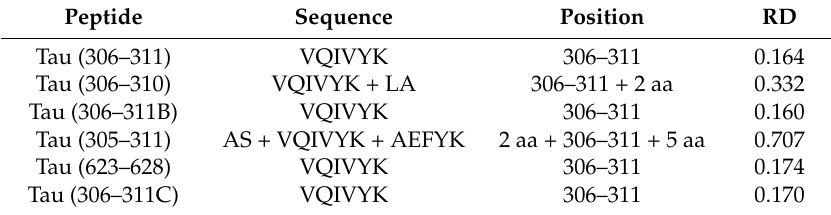
Table 7. Properties of peptides which match the N-terminal fragment of the tau protein. The table lists PDB ID, sequences (indicating which fragments are identical to the tau chain) and RD (T-O-R) values. Positions + aa inform about positions of amino acids present in the chain but these residues are not the object of